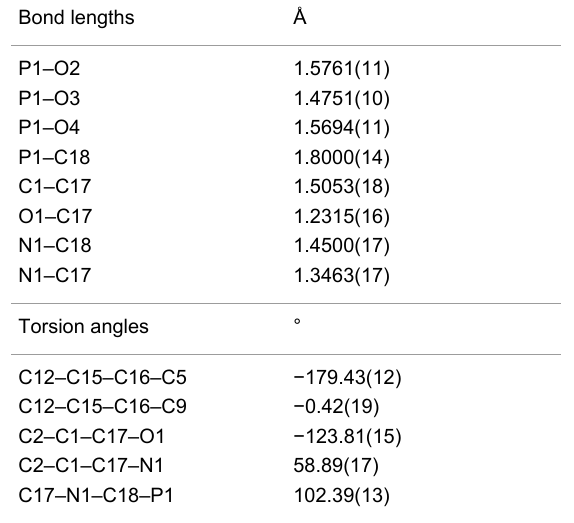
Table 3: Selected geometrical parameters for 3a